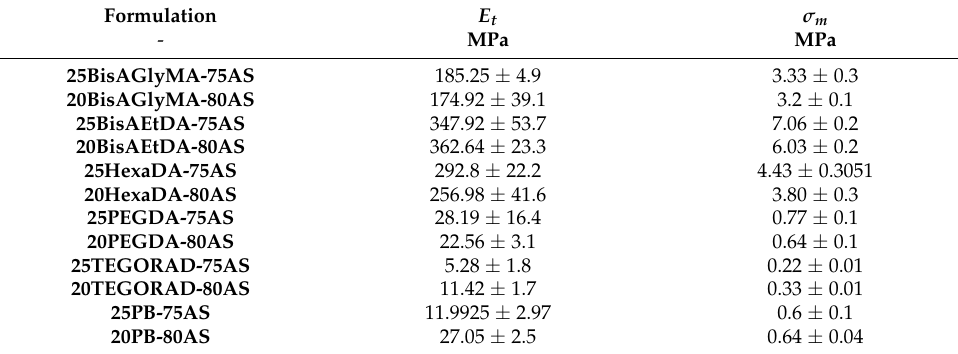
Table 5. Monolayer tensile testing results